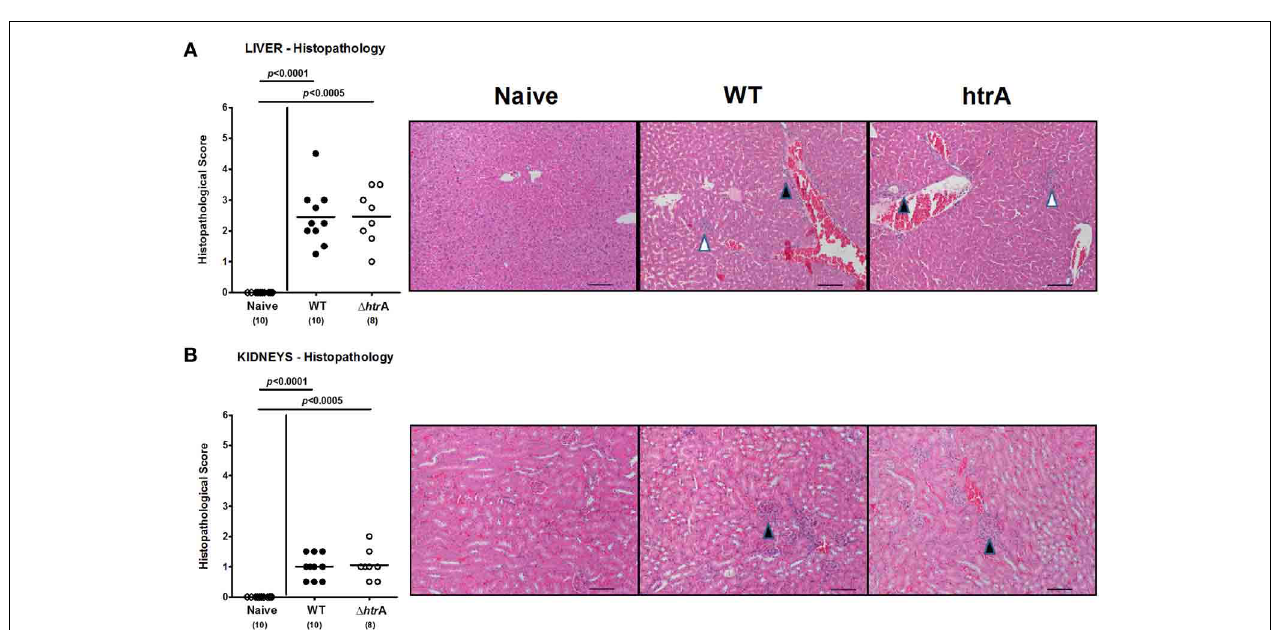
FIGURE 7 | Extra-intestinal immunopathological sequelae following C. jejuni infection of gnotobiotic IL-10 − / − mice. Six days following C. jejuni infection extra-intestinal immunopathological sequelae were assessed in H&E-stained paraffin sections of (A) liver and (B) kidneys by applying respective standardized clinical scoring system and illustrated by